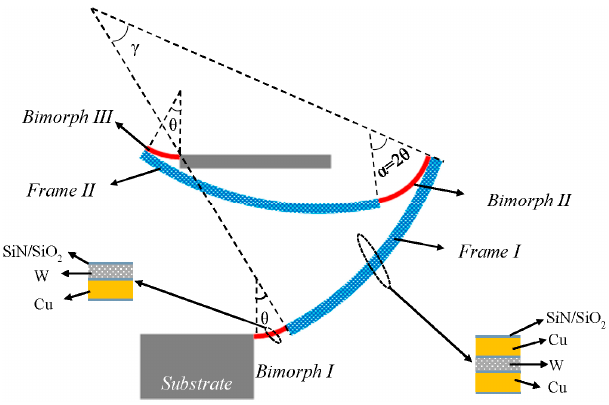
Figure 2. Schematic of the Cu/W-based LSF actuator, with a Cu/W/Cu multimorph as the frame. 2.2. Tilt/Shift Analysis of the LSF Cu/W Bimorph Actuator